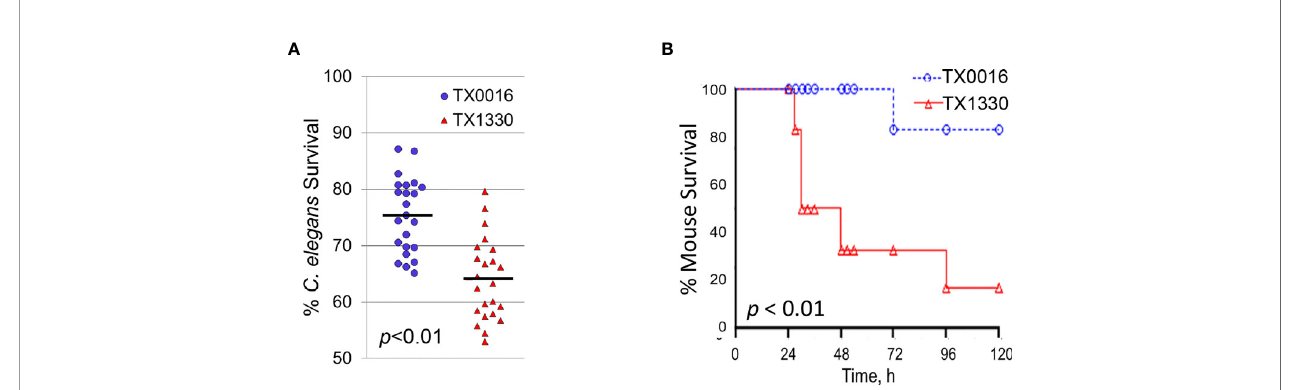
FIGURE 9 | The C. elegans – E. faecium pathogenesis model recapitulates E. faecium virulence. (A, B) Survival curves of (A) C. elegans or (B) mice that were exposed to two E. faecium strains TX0016 and TX1330. All panels show results from pooled biological replicates (each dot in A represents a group of 20 worms). p - values were determined from Student ’ s t -test and are indicated